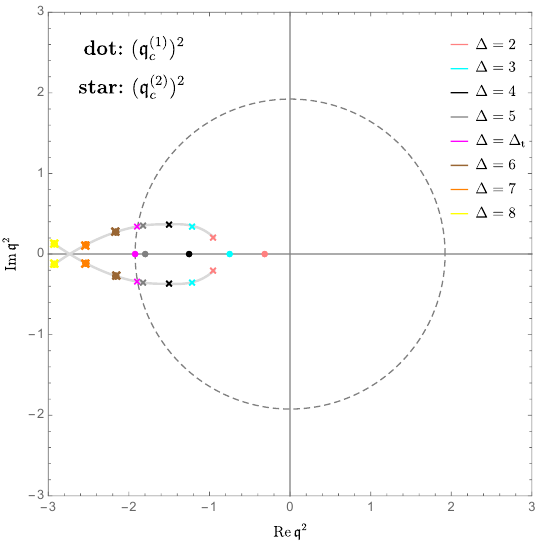
Figure 4 . The location of q 2 in the complex plane for various values of ∆ within the range c 2 ≤ ∆ ≤ 8 . Every dot (cross), corresponding to a particular value of ∆ , lies on a circle whose center is at the origin; the region enclosed by the circle is then the domain of convergence of the derivative expansion about the first (second) QNM associated with that value of ∆ . The dashed circle shows a transition between two regimes: for values of ∆ < ∆ t , the dot does not lie on the circle passing through the crosses. In addition, dots are located in the ( Im q 2 ) -axis. But for ∆ > ∆ t , dots and crosses lie on the same